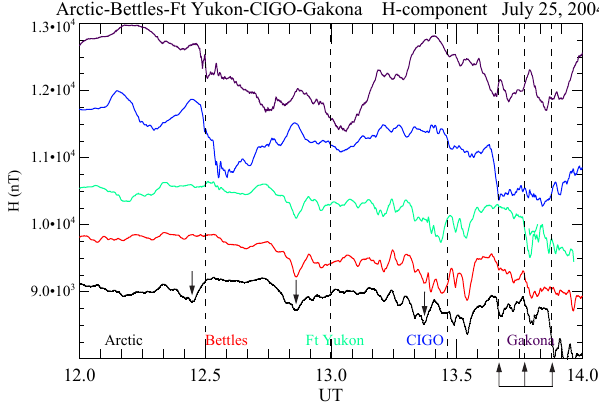
Figure 4. Alaska chain magnetograms during the interval 12:00– 14:00UT. Panels from top to bottom show H component mag- netograms from stations ordered by increasing magnetic lati- tude: Gakona (top; 63.6 ◦ MLAT), CIGO (65.4 ◦ MLAT), Ft. Yukon (67.4 ◦ MLAT), Bettles, and Arctic Village (68.7 ◦ MLAT; bottom panel).